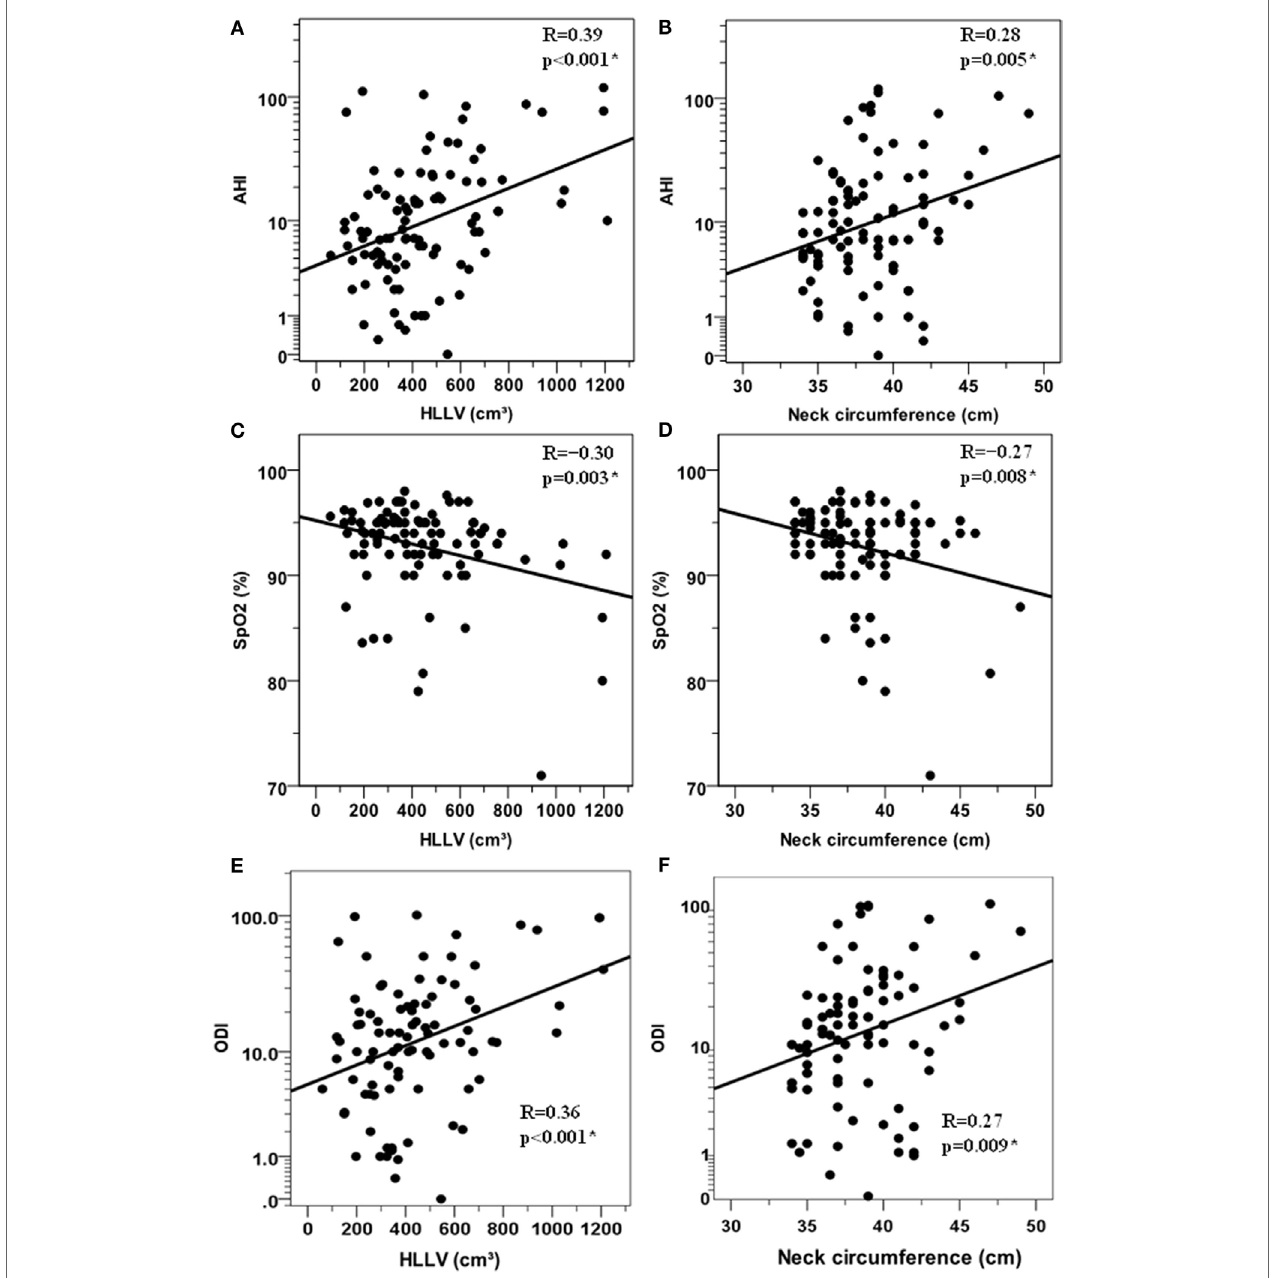
FigUre 1 | Correlations between anthropometric variables and respiratory paramenters in the cohort of 97 obese women. Relationships between the hepatic left lobe volume (HLLV) and the apnea/hypopnea index (AHI) (a) the mean percent oxygen saturation [SpO 2 , (c) ] and the oxygen desaturation index (ODI) (e) . Relationship between neck circumference and AHI (b) mean percent oxygen saturation [SpO 2 , (D) ] and (ODI), (F) . AHI and ODI values are reported on a logarithmic scale, i.e., LOG 10 (1 + AHI) and LOG 10 (1 + ODI) which can handle zero values. R: Pearson’s correlation coefficient (* p <